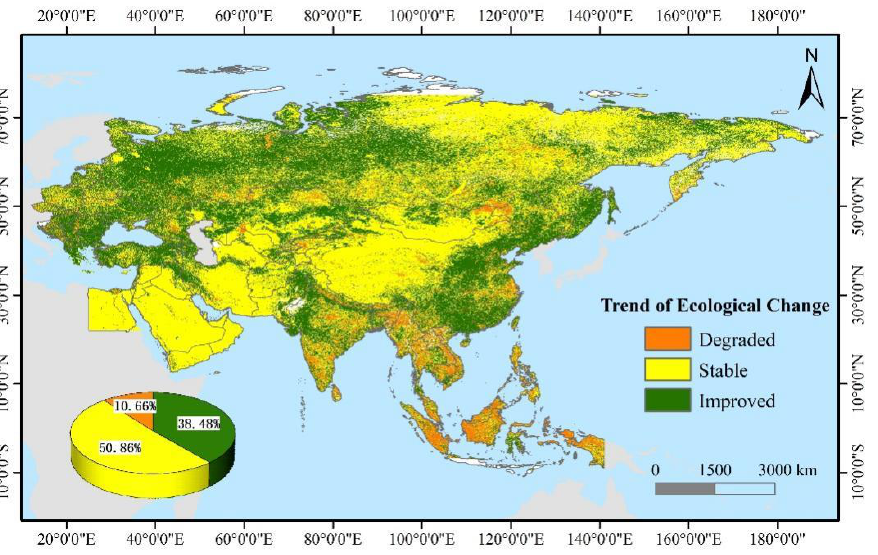
Figure 5. Spatial distribution of ecological changes in the Pan-Third Pole region from 2000 to 2020. The trends of ecological changes in the Pan-Third Pole region varied widely among different countries, but with some regularities. European countries generally had a larger share of ecologically improved areas, which indicated a clear trend toward better ecological conditions in the European region over the past 20 years. The percentages of the degraded ecological areas in East Asian and South Asian countries were relatively large. Especially, the percentage of the countries in the coastal area of southern East Asia was significantly larger than that of other countries, which showed that the ecological environment in the coastal countries of southern East Asia had been seriously damaged in recent years. The changes in the ecological quality of Central Asian and Middle Eastern countries had a smaller percentage, and the percentage of ecological degradation regions was also smaller, which indicated that the ecological quality of several Central Asian and Middle Eastern countries had a trend of steady improvement. The improved ecological environments of Armenia, Azerbaijan, and Turkey, which were in the southern part of the Middle East, had a significantly larger proportion of areas than other countries in the Middle East (Figure 6). In addition, Bulgaria and Moldova in Europe and Armenia in Middle East had the highest proportion of ecological improvement areas, accounting for 88.18%, 85.55%, and 84.12% of their total area, respectively. The ecological quality of Oman, Saudi Arabia, and the United Arab Emirates in the Middle East were basically stabilized, with 98.24%, 97.57%, and 96.40%, respectively. The most obvious was that the country with severe ecological degradation was Brunei in East Asia, with 89.68%, which was far more than other countries in the Pan-Third Pole region (Figure